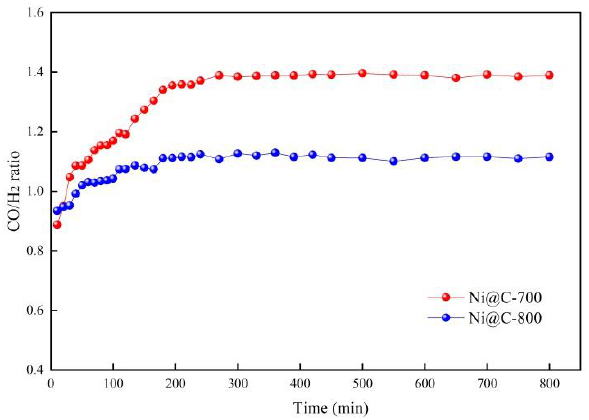
Figure 5. Variation of dry reforming of methane (DRM) conversion of ( a ) CO 2 and ( b ) CH 4 over Ni@C-700, Ni@C-800, Ni@C-900, and C-900 (Conditions: 700 ° C; VHSV=0.17 Lg –1 h –1 ).